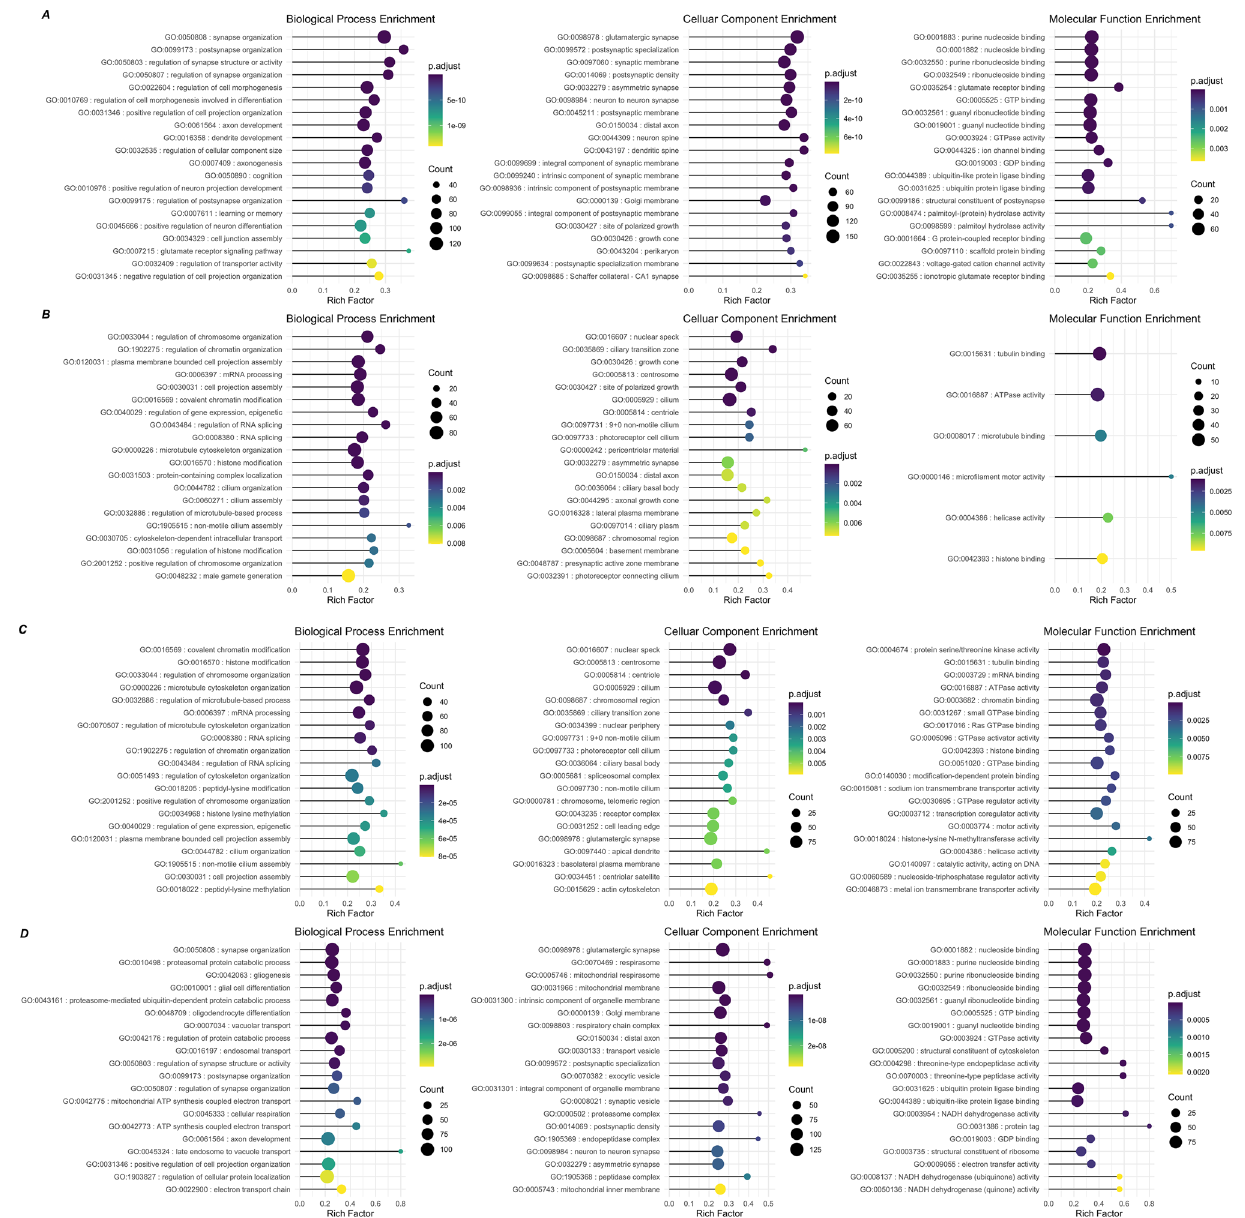
Figure 4. Gene ontology (GO) analysis of DEGs. Biological, Cellular, and Molecular processes that were significantly enriched due to Pb exposure associated with ( A ) upregulated or ( B ) downregulated genes (EPN_ non-enriched vs Control_non-enriched). Panels ( C ) and ( D ) similarly show Biological, Cellular, and Molecular processes that were significantly enriched in response to environmental enrichment in Pb exposed animals (EPN_enriched vs EPN_non-enriched) and associated with upregulated or downregulated genes,